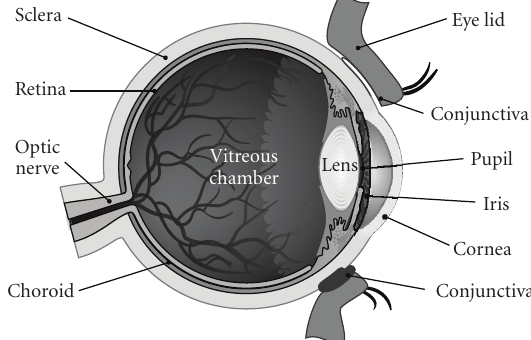
Figure 1: Diagram of the human eye (illustration by Michael K. Krider).